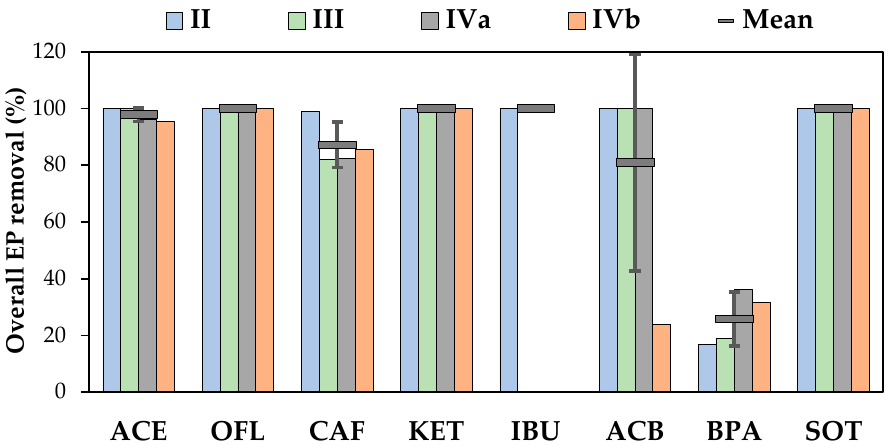
Figure 5. Removal efficiency of each EP through the overall HD–VF–PD system by period (bars) and mean and standard deviation in the overall period (marker and error bars). See Table 1 for operational conditions for the different periods and Table 4 for pollutant abbreviations.